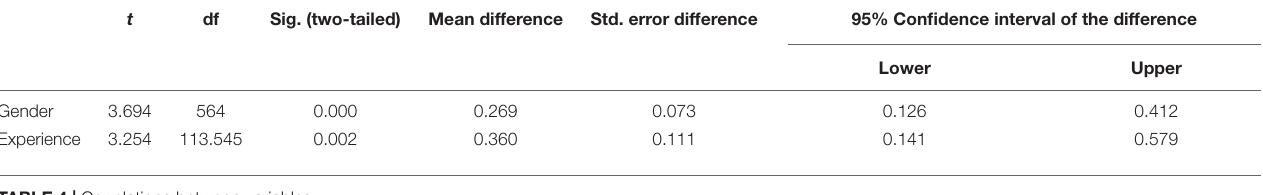
TABLE 4 | Correlations between